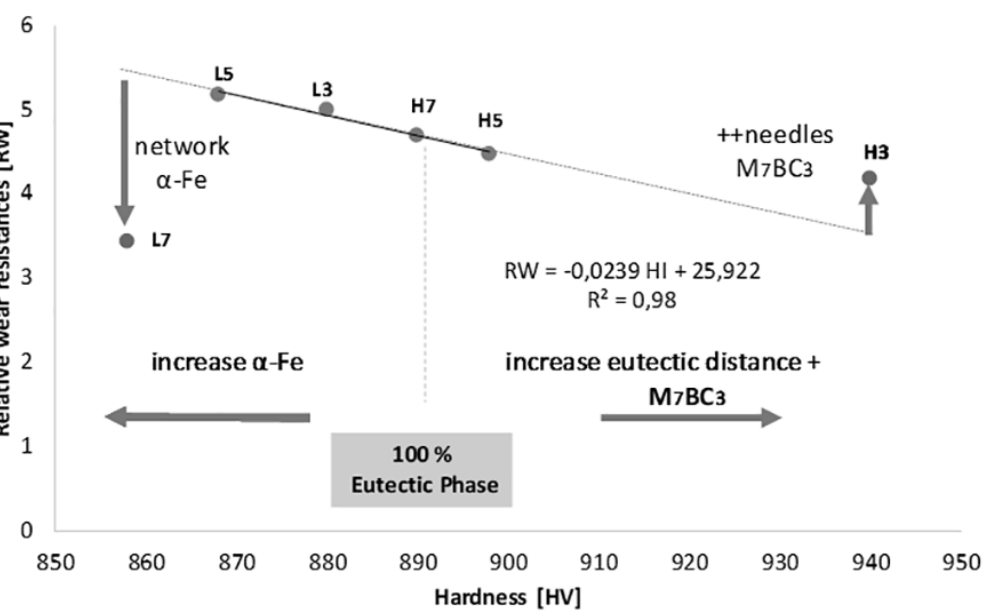
Figure 7. Weight of loss for each